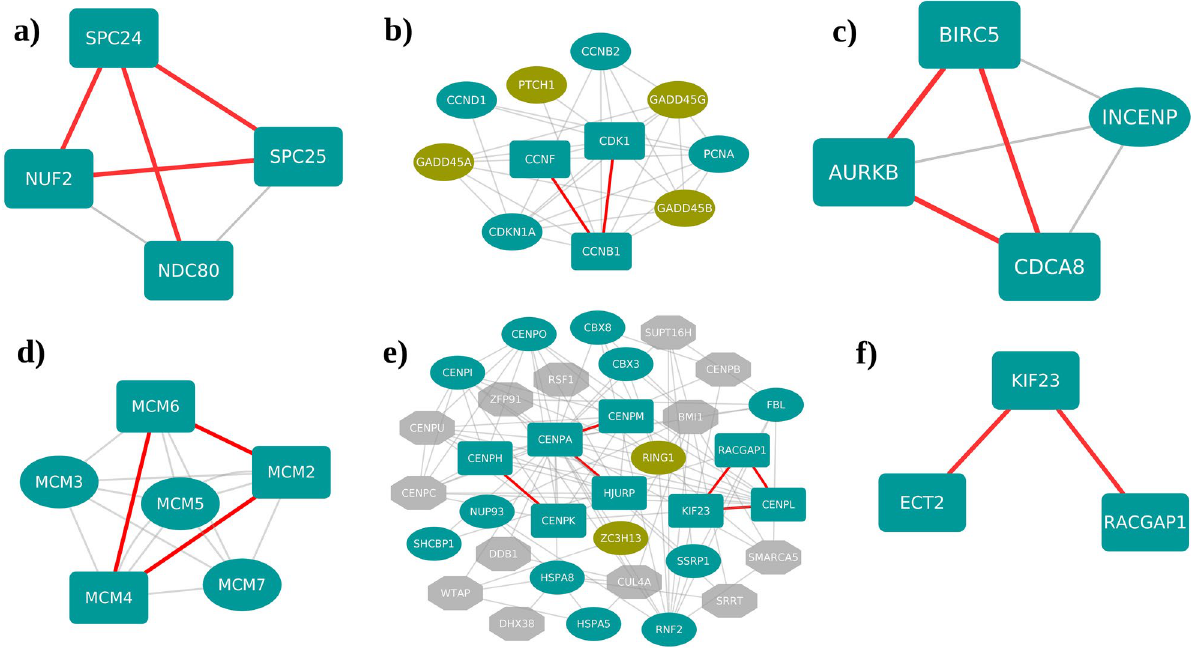
Figure 3. Interactions of the projected upregulated protein complexes. Rectangle shaped nodes are part of the upregulated projected network and the ellipse shaped nodes are differentially regulated components of the complex. Hexagons—other components of the complex. The red colored edges are the captured interactions between complex components in the projected network. (Blue nodes—upregulated, green nodes— downregulated and grey nodes – not differentially regulated) ( a ) NDC80 kinetochore complex, ( b ) cell cycle kinase complex, ( c ) chromosomal passenger complex (CPC), ( d ) mini-chromosome maintenance (MCM) protein complex, ( e ) Centromere (CEN) complex and ( f ) ECT2–KIF23–RACGAP1